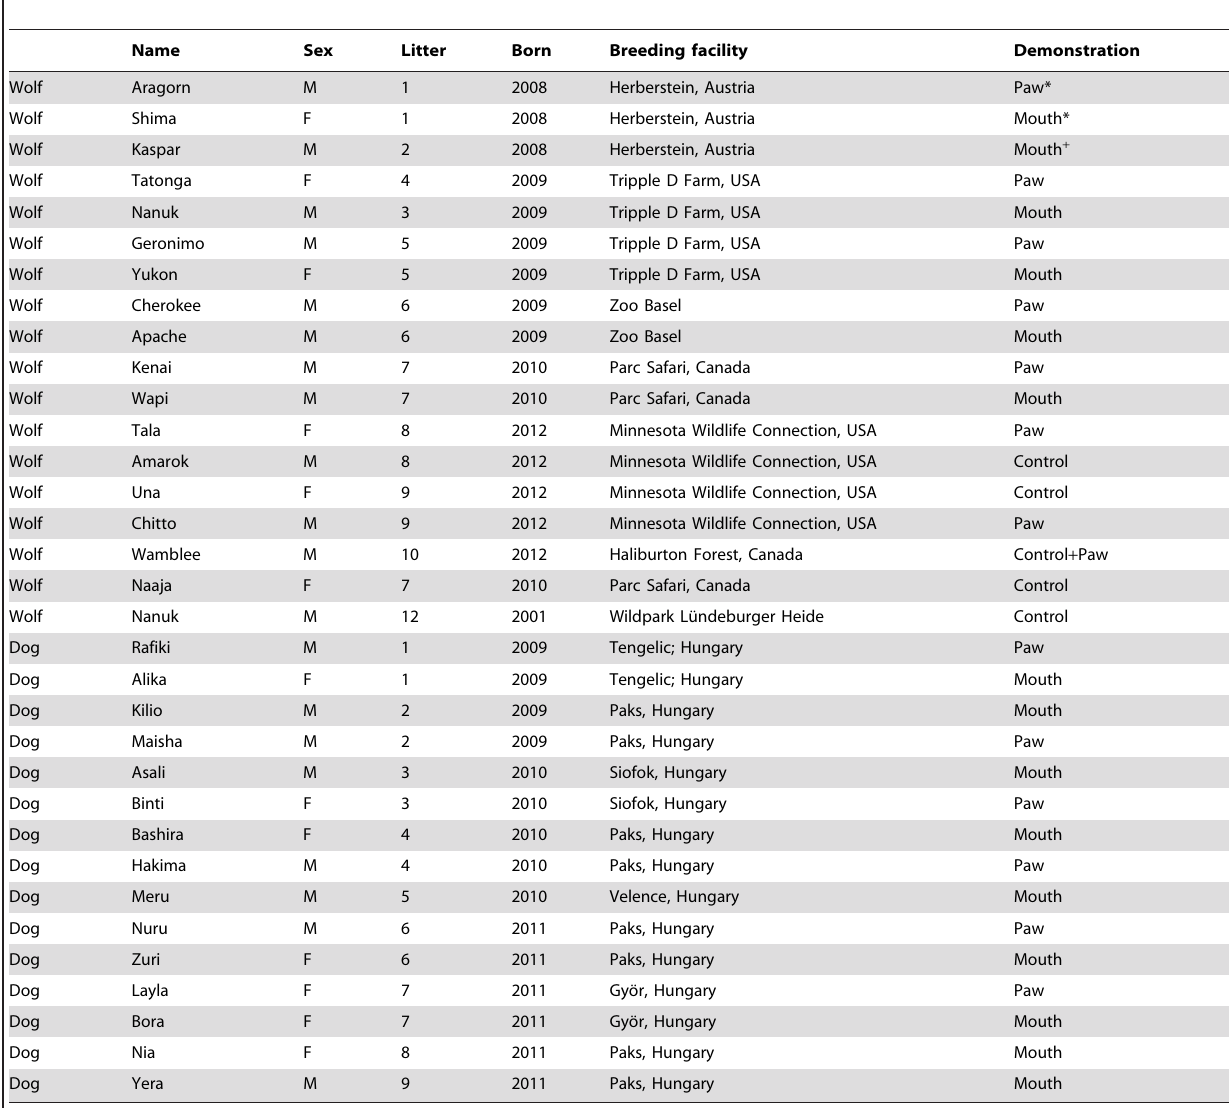
Table 1. List of animals, indicating genetic relationships (litter), sex ( M ale/ F emale), age, origin and type of demonstration